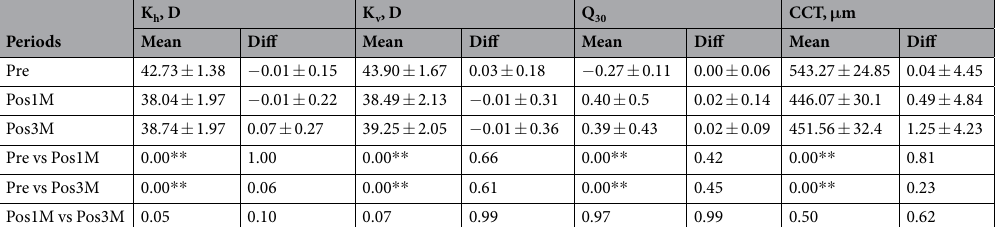
Table 1. Mean and inter-measurement difference of conreal biometric parameters between two successive measurements among three periods. Pre means the period pre operation, Pos1M means 1 month post LASIK, Pos3M means 3 months post LASIK. Mean represents the average of the first and second measurements result, while Diff represents the inter-measurement-difference of two successive measurments (second mesurement – first mesurement), * means P < 0.05, ** means P < 0.01.